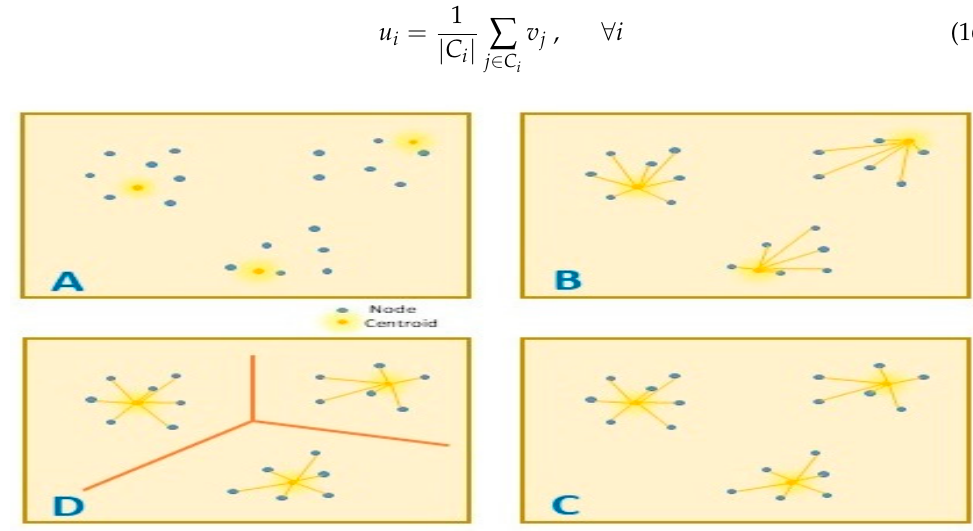
Figure 7. K-Means clustering procedure [21]. ( A ) Initial K-value selection, ( B ) Optimal centroid location selection, ( C ) Cluster centroid updates, ( D ) Final cluster centroid location.